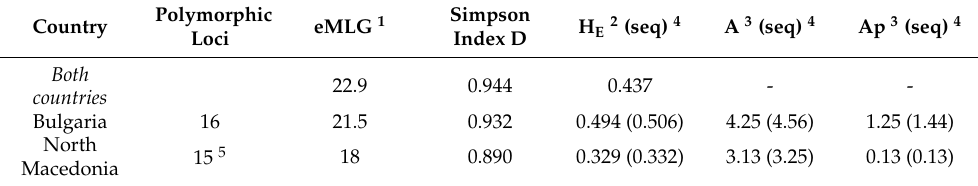
Table 3. Genetic diversity parameters of X. euvesicatoria from Bulgaria ( n = 45) and North Macedonia ( n = 43) estimated from the two MLVA-16 datasets (VNTR-rep and VNTR-seq). Country